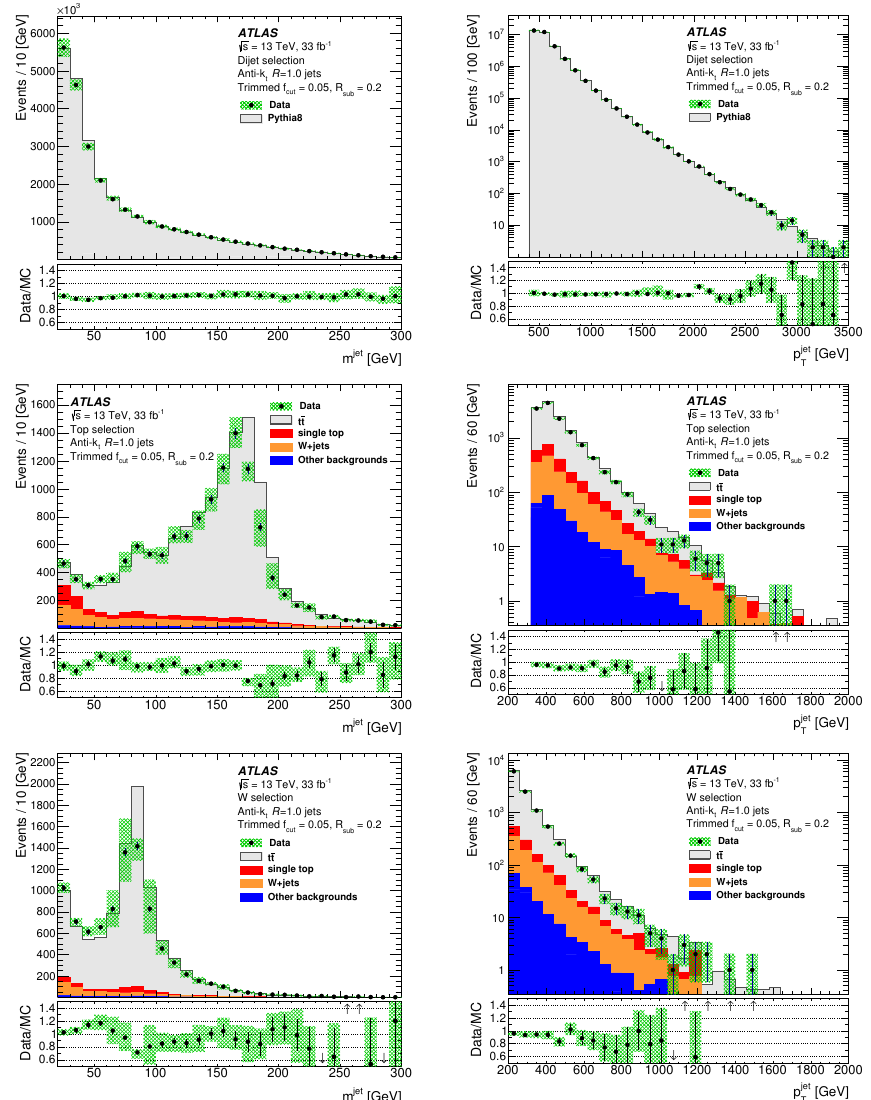
Figure 2 . Comparison of detector-level distributions in data and MC simulation for trimmed large- radius jets for dijet (top row), top (middle row), and W (bottom row) selections. For the top and W selections, jet mass requirements have not been applied. The mass is shown in the left column, while the transverse momentum is in the right column. The shaded bands represent the combined statistical and systematic uncertainty. Contributions from dominant backgrounds are shown for the top and W selections, while the smaller contributions from other processes are grouped under other backgrounds.